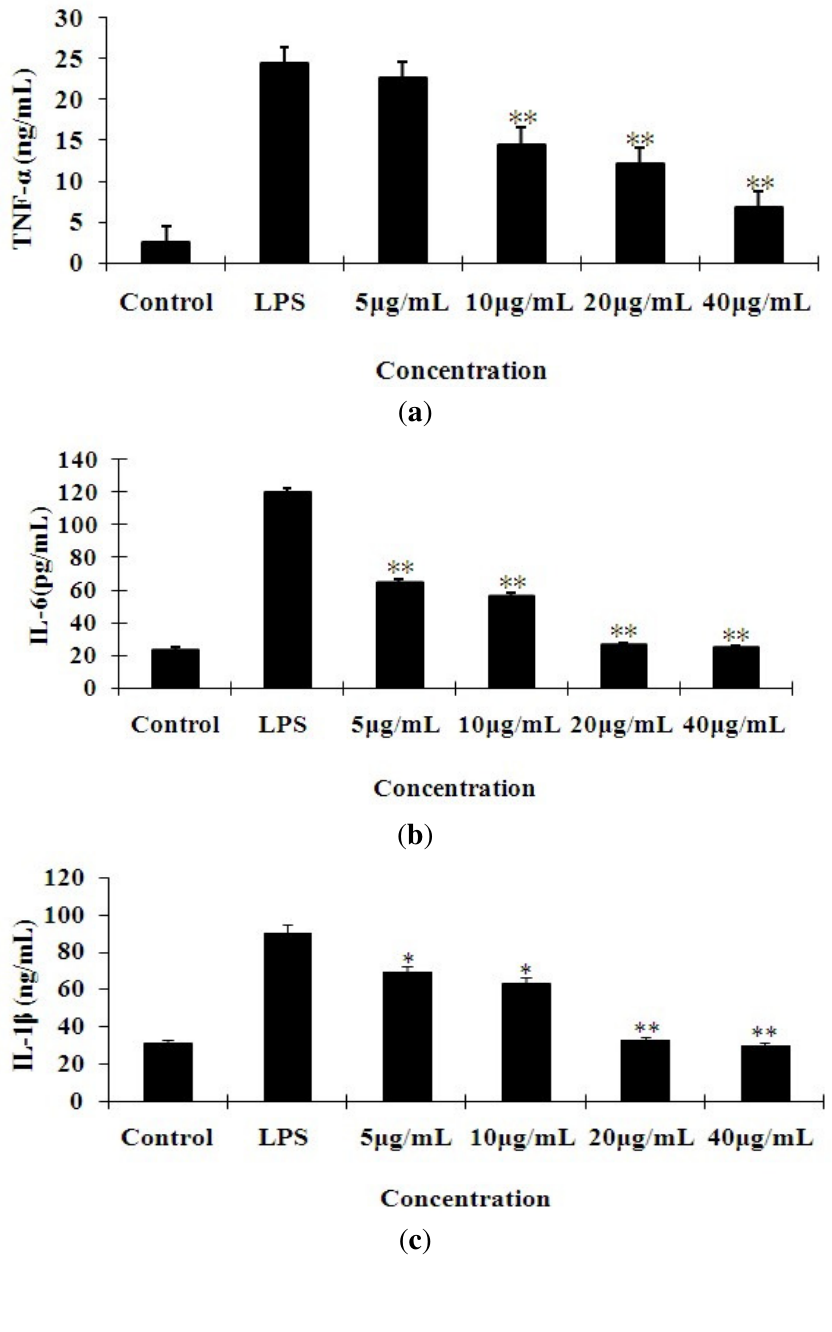
LPS. 7- O -methylnaringenin markedly inhibited LPS-induced activation of p-ERK1/2, p-JNK/MAPKs in a dose-dependent manner. But there were no significant changes in p-p38/MAPKs. Figure 3. Effect of different concentrations of 7- O -methylnaringenin on the secretion of TNF- α ( a ), IL-6 ( b ) and IL-1 β ( c ) in LPS-stimulated RAW 264.7 cells. The cells were pretreated with different concentrations (5, 10, 20 and 40 µ g/mL) of 7- O -methylnaringenin for 1 h prior to stimulation with 1 µ g/mL of LPS for 24 h. Control values were obtained in the absence of LPS or 7- O -methylnaringenin. The values are means ± SEM of three independent experiments. * p < 0.05, ** P < 0.01 vs . LPS